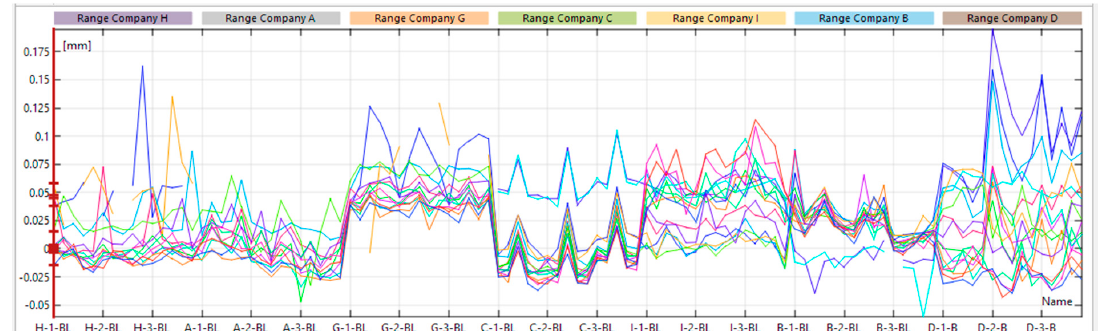
Figure 20. Deviation graph of the cross wall thickness compared to the nominal CAD dimension produced with GOM Inspect for each cross from each company (in the graph, company F is referred to as company I).